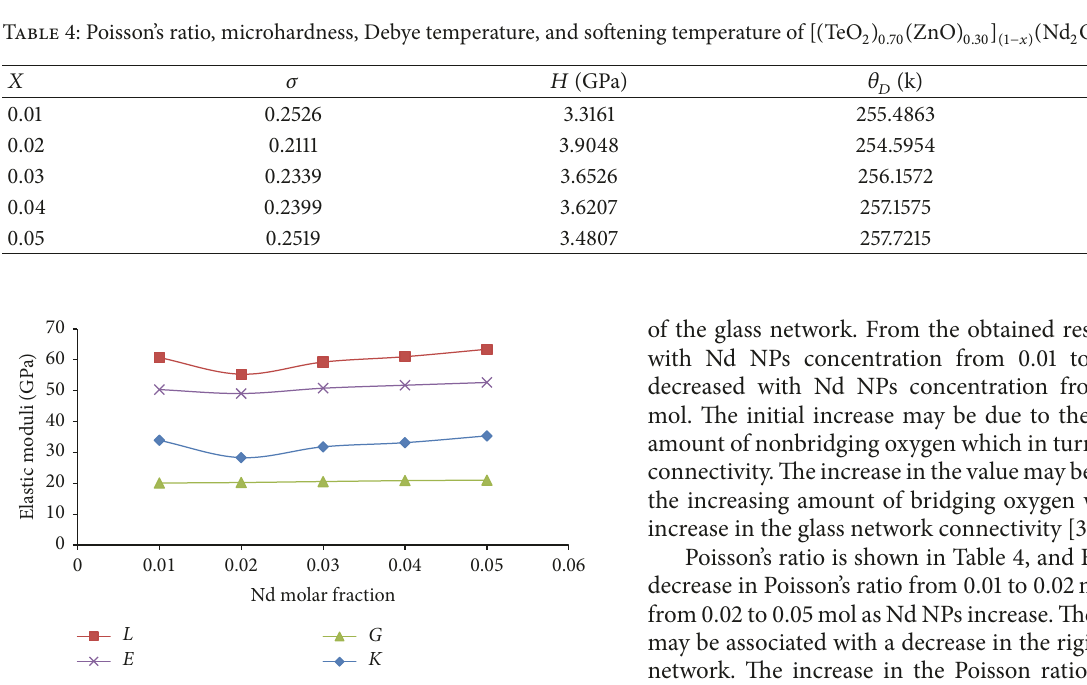
Figure 6: Elastic moduli of [(TeO 2 ) 0.70 (ZnO) 0.30 ] (1−𝑥) (Nd 2 O 3 NPs) (𝑥)